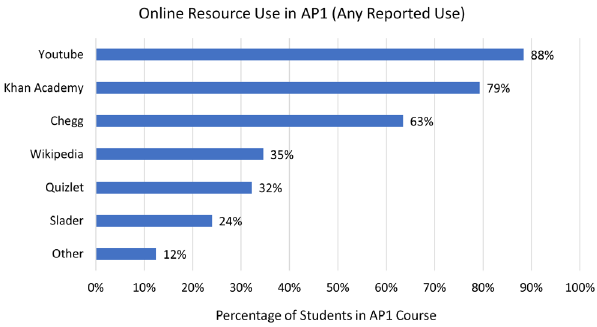
FIG. 7. Percentage of students in Analytical Physics 1 who reported any use of a given online resource ( N